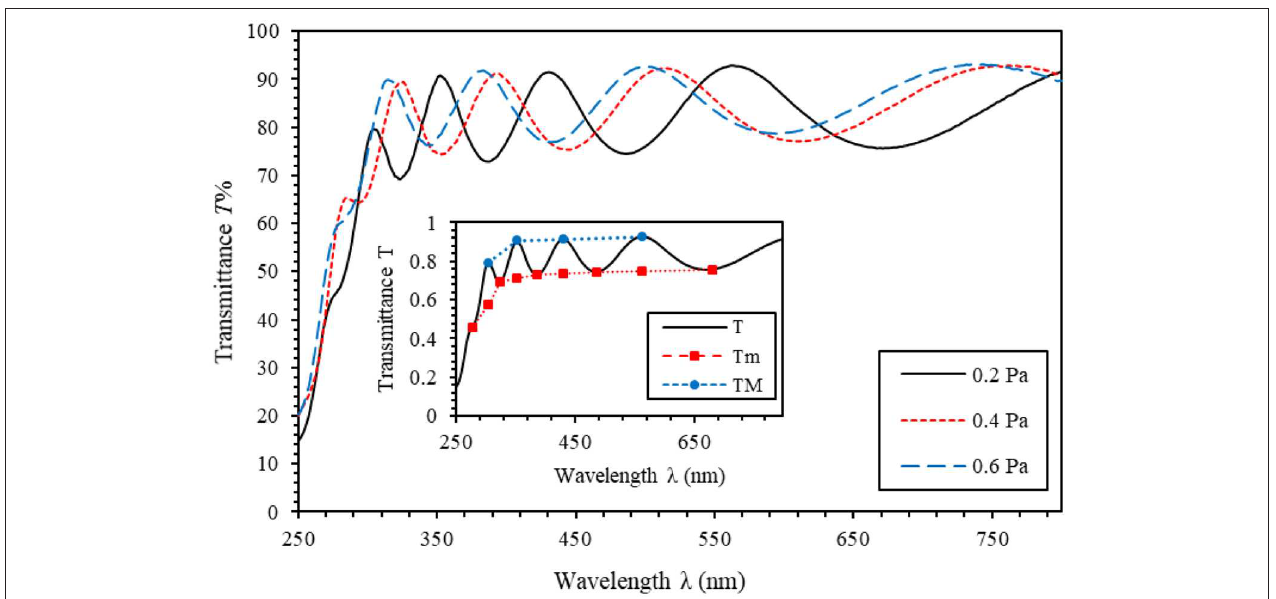
FIGURE 4 | Transmittance spectra of sputtered aluminum nitride (AlN) thin films at 300W and with different back pressures (0.2, 0.4, and 0.6Pa). The figure inset shows a typical transmission spectrum of sputtered AlN thin films at a back pressure of 0.2Pa; T M and T m are the experimental curves as explained in the text.